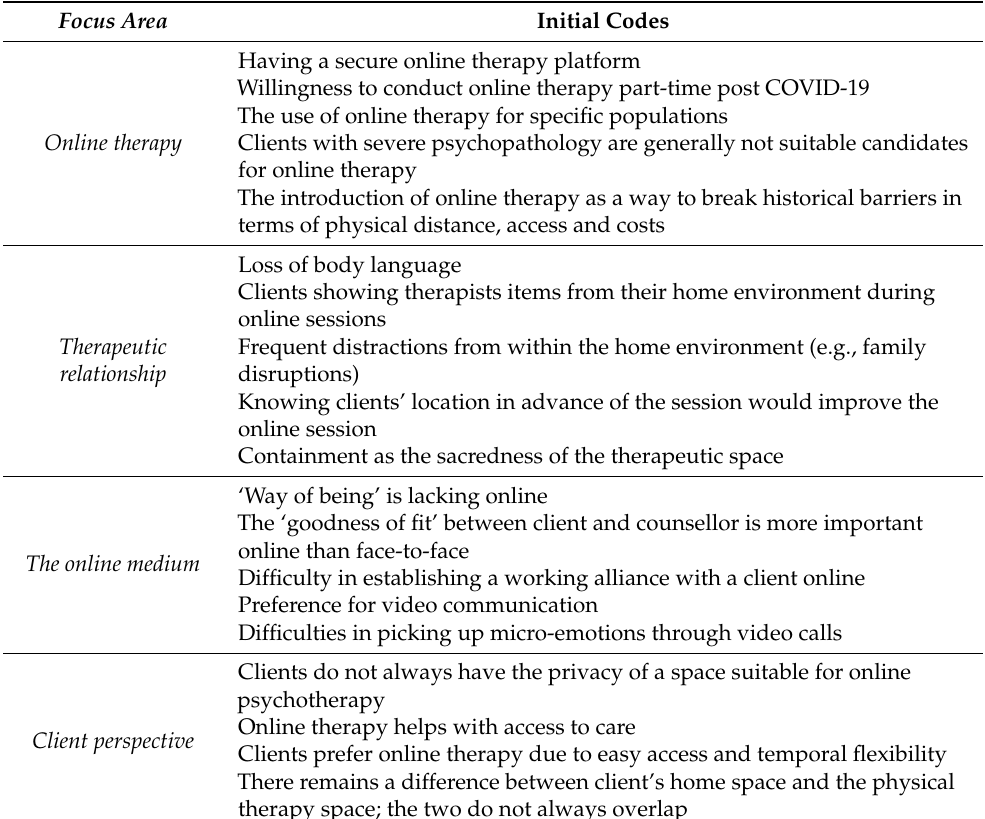
Table 1. Generating initial codes—example codes.